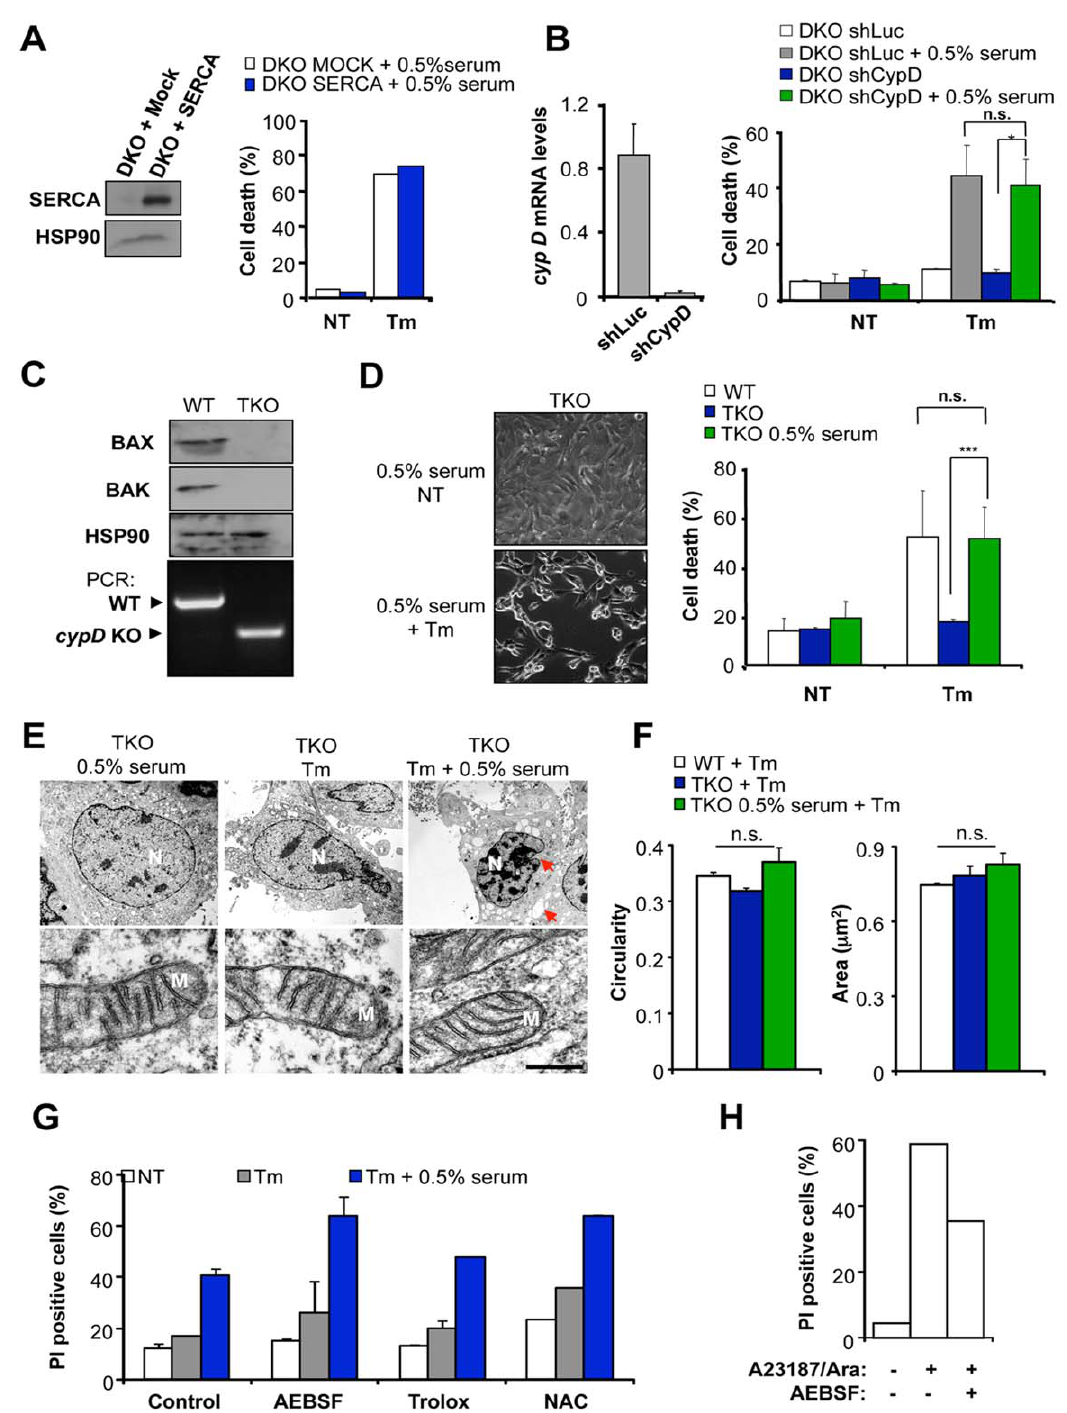
Figure 6. Cell death of BAX and BAK DKO cells is independent of CypD expression. ( A ) Right panel: BAX/BAK DKO cells stably transfected with a SERCA expression vector or an empty vector were treated with 10 m g/ml Tm or left untreated (NT) in cells pre-incubated for 2 h with cell culture media containing 0.5% serum. After 24 h, cell viability was analyzed by PI staining and FACS analysis. Left panel: SERCA expression levels were determined by Western blot analysis in the two cell lines presented. As loading control HSP90 levels were determined. Data is representative of two independent experiments. Mean is presented. ( B ) BAX/BAK DKO cells were stably transduced with lentiviral vectors expressing an shRNA against cypD mRNA (shCypD) or control shRNA against the luciferase mRNA (shLuc), and the mRNA levels of cypD were determined by real time PCR and normalized by the levels of beta actin (left panel). Then, in these cells, cell viability was analyzed after treatment with 10 m g/ml Tm in cells grown in regular cell culture conditions or pre-incubated for 2 h in media containing 0.5% serum. Untreated cells (NT) are also presented. After 24 h cell death was monitored by PI staining and FACS analysis (right panel). Mean and standard deviation is presented. p value for Tm treatment was calculated with Student’s t-test in a total of three independent experiments for indicated comparisons. n.s.: non significant ( C ) Confirmation of the genotype of BAX/BAK/CypD triple knockout (TKO) cells. Upper panel: The levels of BAX and BAK proteins were monitored by Western blot in TKO and WT control